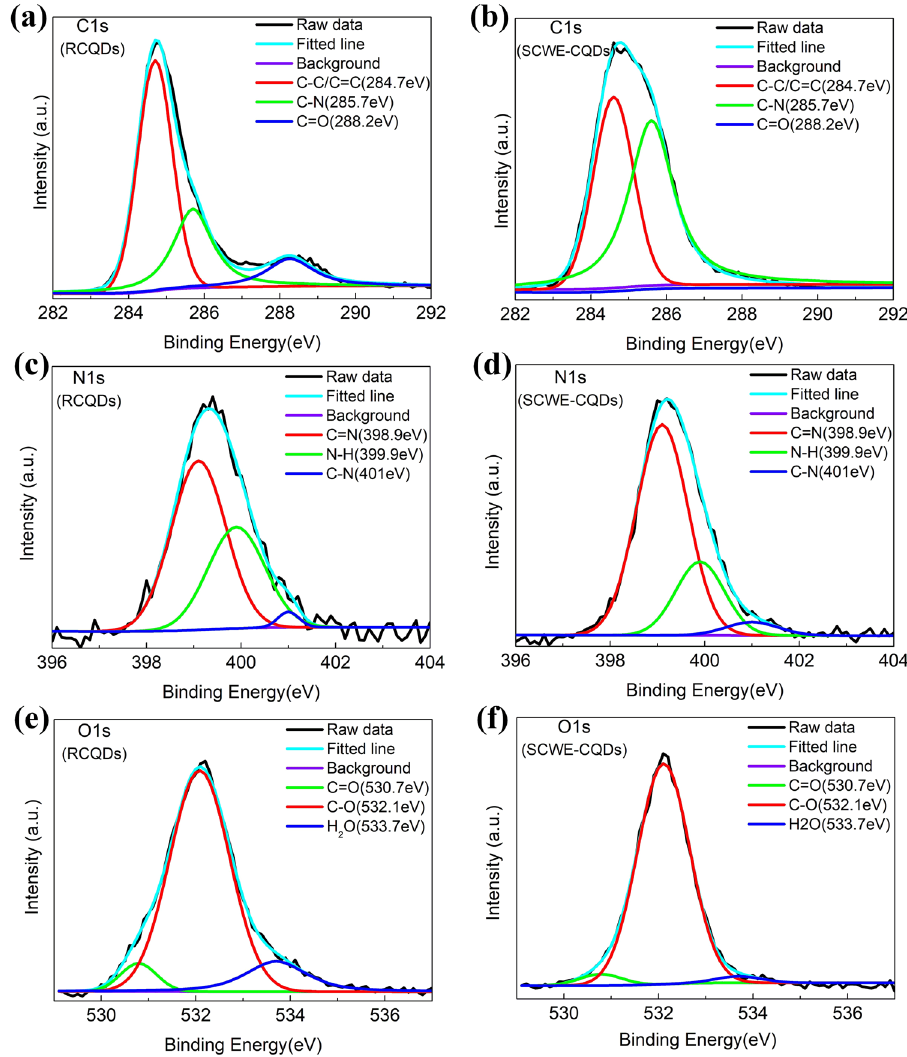
Figure 7: High - resolution narrow scan spectra of ( a ) C1s, ( b ) N1s, and ( c ) O1s for the RCQDs, and ( d ) C1s, ( e ) N1s, and ( f ) O1s for the SCWE - CQDs.